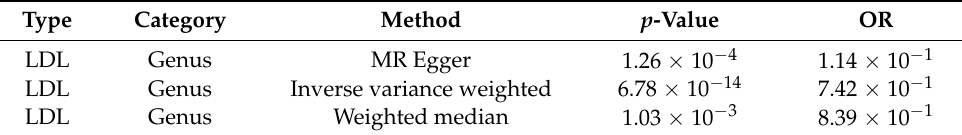
Table 7. Mendelian randomization results of Streptococcus and blood lipid levels.